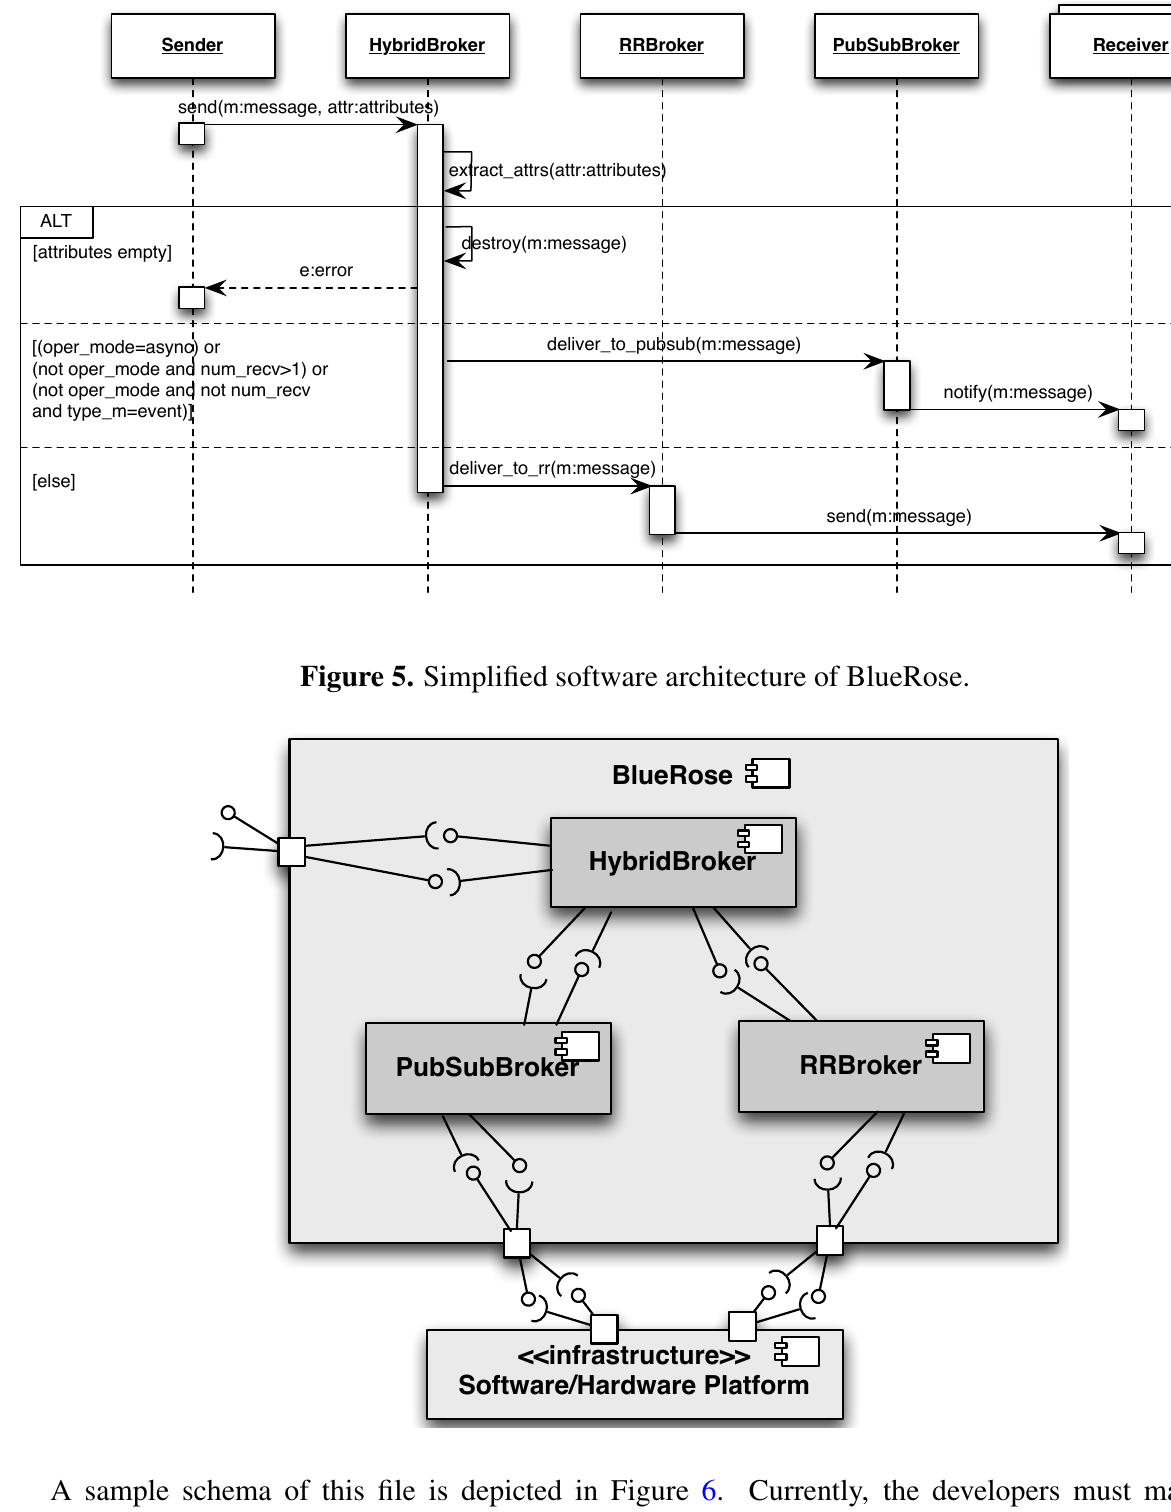
Figure 4. Run-time operation of the proposed hybrid broker as a UML sequence diagram.